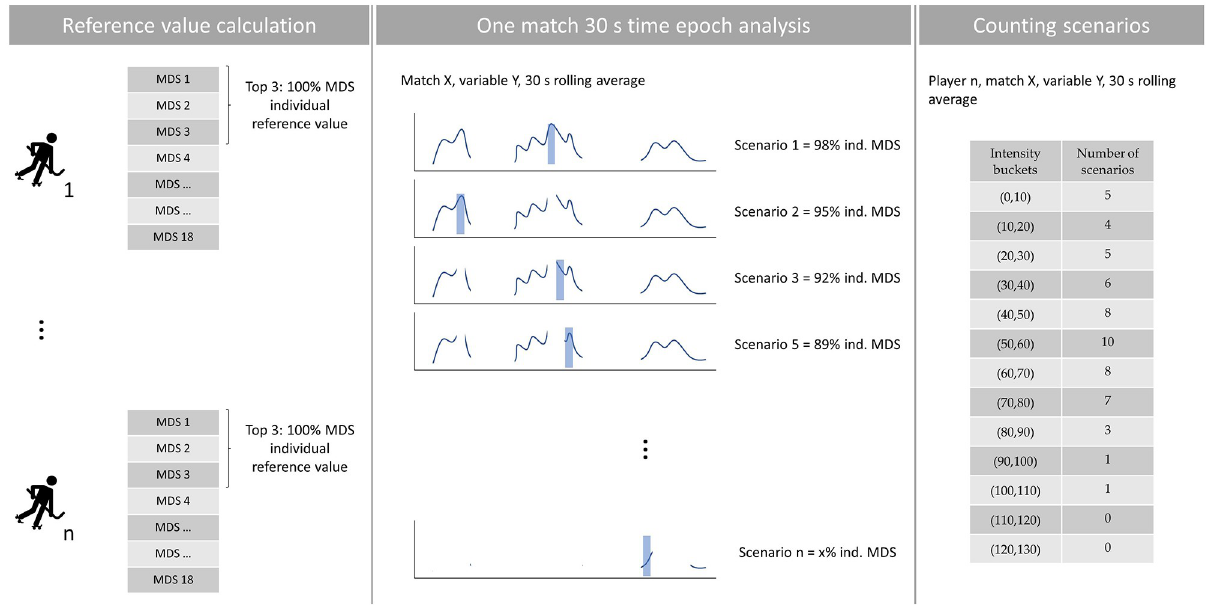
PLOS ONE | https://doi.org/10.1371/journal.pone.0282788 March 9,